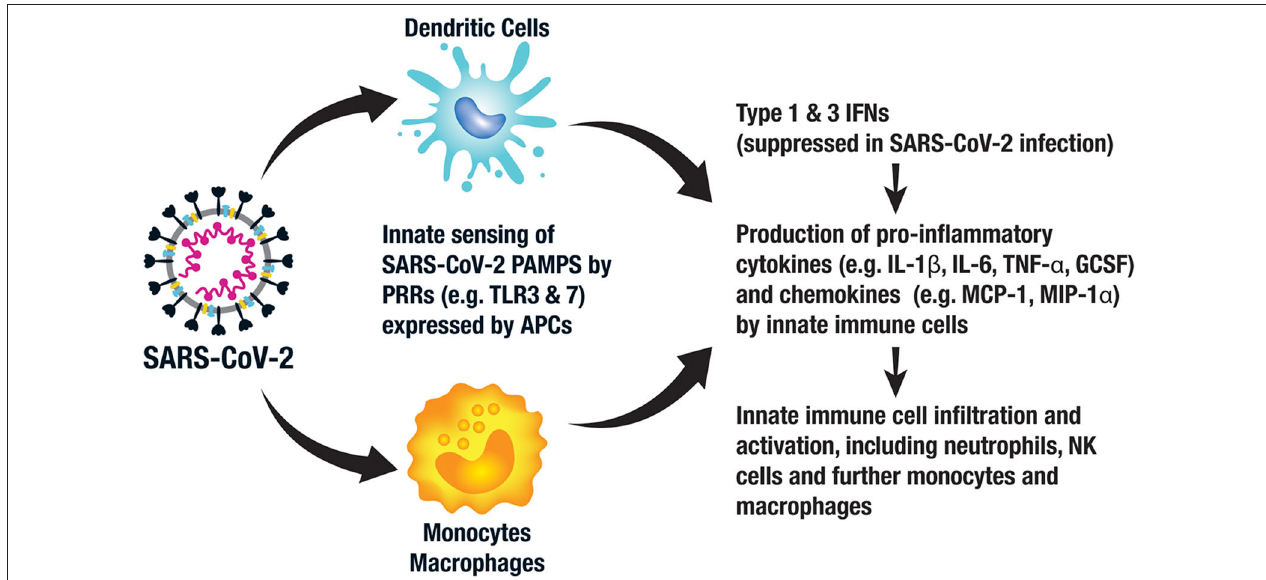
FIGURE 2 | Key components of the innate immune response to SARS-CoV-2. Antigen presenting cells (APCs), such as monocytes, macrophages, and dendritic cells (DCs), recognize pattern associated molecular patterns (PAMPs) expressed by SARS-CoV-2 via their pattern recognition receptors (PRRs), such as toll-like receptor (TLR) 3 and 7. This activates intracellular signaling pathways leading to the expression of type 1 and 3 interferons (IFNs), which in turn activate innate immune cells to produce pro-inflammatory cytokines and chemokines. This leads to an influx and activation of neutrophils, further APCs and other innate immune cells, such as natural killer (NK)